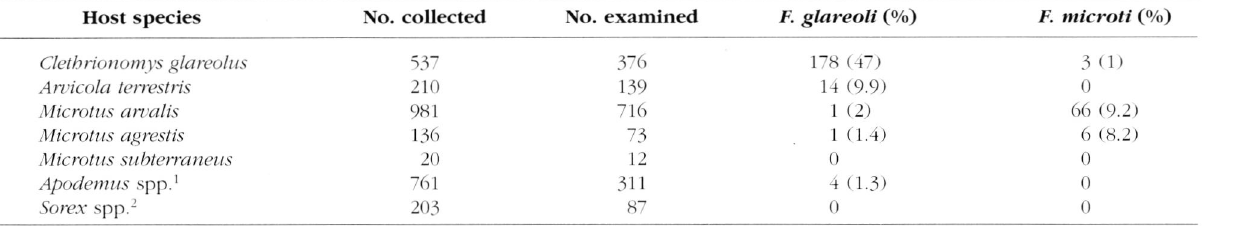
Table II. - Prevalences and host range in a small mammal community infected by